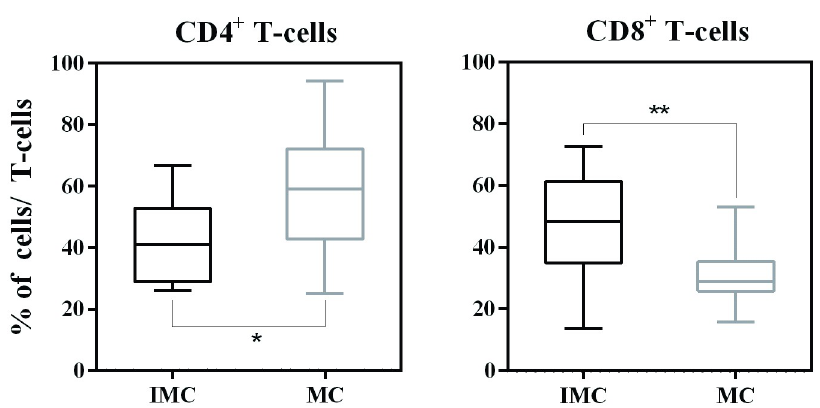
Fig 4. Immunophenotypic profile of tumour-infiltrating lymphocytes in female dogs with mammary carcinoma. Analysis of tumour-infiltrating T-cell subsets from inflammatory mammary carcinoma (IMC) and mammary carcinoma (MC) samples. Data are expressed as the percentage of positive cells among either CD4+ or CD8+